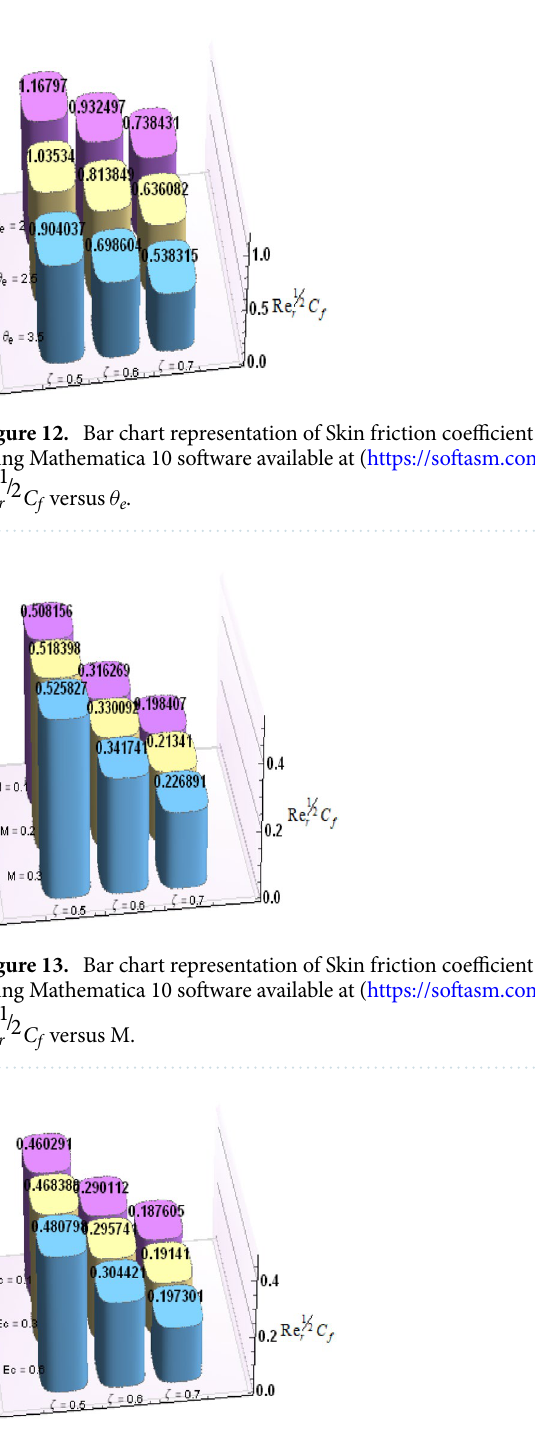
Figure 14. Bar chart representation of Skin friction coefficient and Nusselt number for different parameters using Mathematica 10 software available at (https:// softa sm. com/ wolfr am- mathe matica- 10-4- full- crack/). Re1 /2 r C f versus